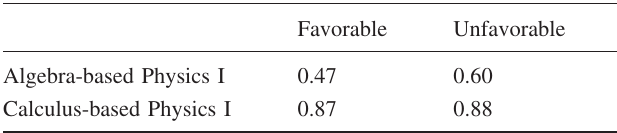
TABLE VII. Correlations between student shifts with different instructors. LSRU, CLASS V.3; algebra-based instructors had quite different teaching philosophies while calculus-based instructors had very similar ideas about teaching.